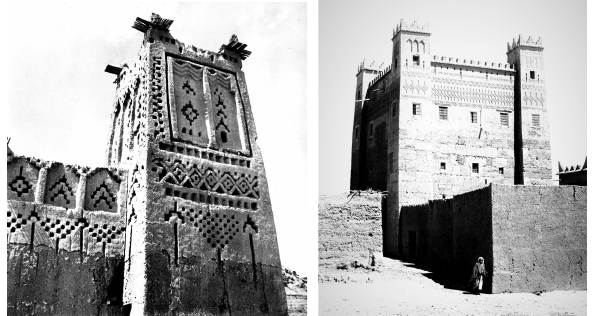
Figure 3. Left: Tighremt Aït Aicha (Bou Taghrar). Right: Tighremt Aït Said (Kelaat M’Gouna). Fuente: Jacques-Meunié, 1962.